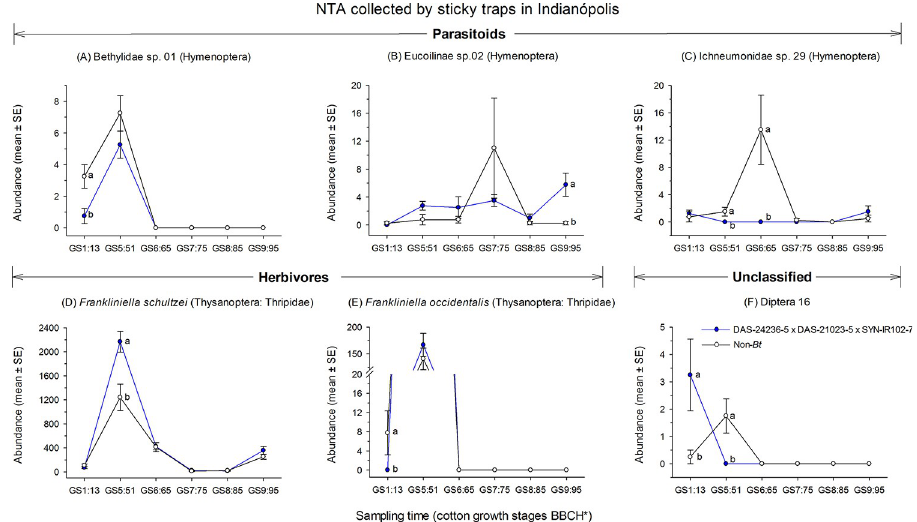
Fig 7. Abundance of aerial-dwelling arthropods collected via sticky card trapping in a cotton trial at Indiano´polis (2014/2015 cropping season). Means ( ± SE) within sampling time followed by different letters are significantly different by two-way RM-ANOVA ( α = 0.05). � Phenological growth stages of cotton classified according to Munger et al. (1998). DAS-21023-5 × DAS-24236-5 × SYN-IR102-7 plots during the GS7:75 and GS8:85, respec- tively (Fig 8B and 8C). The abundance of Eucoilinae sp. 02 in DAS-21023-5 × DAS-24236- 5 × SYN-IR102-7 plots compared with non- Bt cotton was significant lower in GS6:65 and higher during GS8:85, while phorid flies in non- Bt cotton plots were more abundant during GS8:85 (Fig 8D and 8E). The predator Coenosia sp. was more abundant in non- Bt cotton at GS7:75 compared with DAS-21023-5 × DAS-24236-5 × SYN-IR102-7 plots. However, during the GS8:85 cotton growth stage, Coenosia sp. abundance was significantly lower in non- Bt cot- ton plots (Fig 8F). In DAS-21023-5 × DAS-24236-5 × SYN-IR102-7 plots, the detritivore-con-